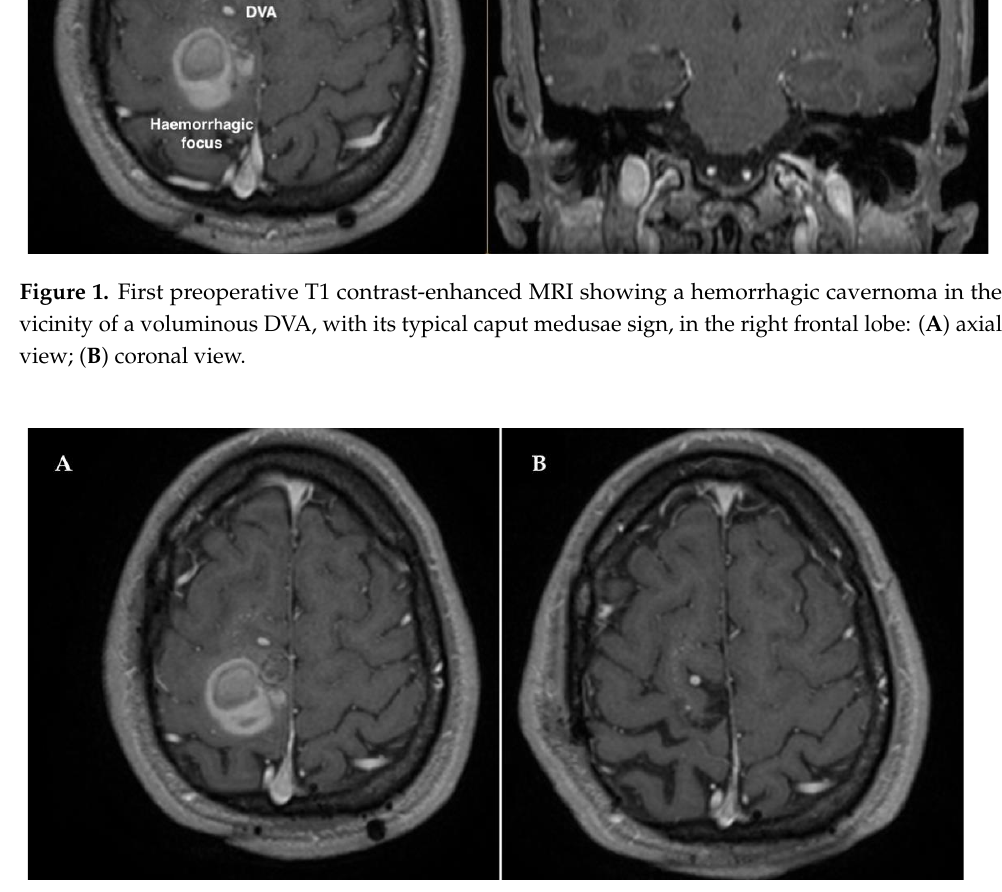
Figure 1. First preoperative T1 contrast-enhanced MRI showing a hemorrhagic cavernoma in the vicinity of a voluminous DVA, with its typical caput medusae sign, in the right frontal lobe: ( A ) axial view; ( B ) coronal view.